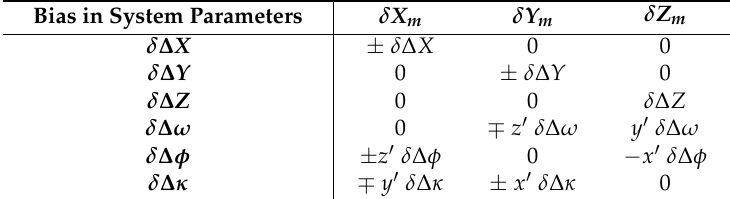
Table 1. Impact of bias in each of the mounting parameters on 3D point coordinates.